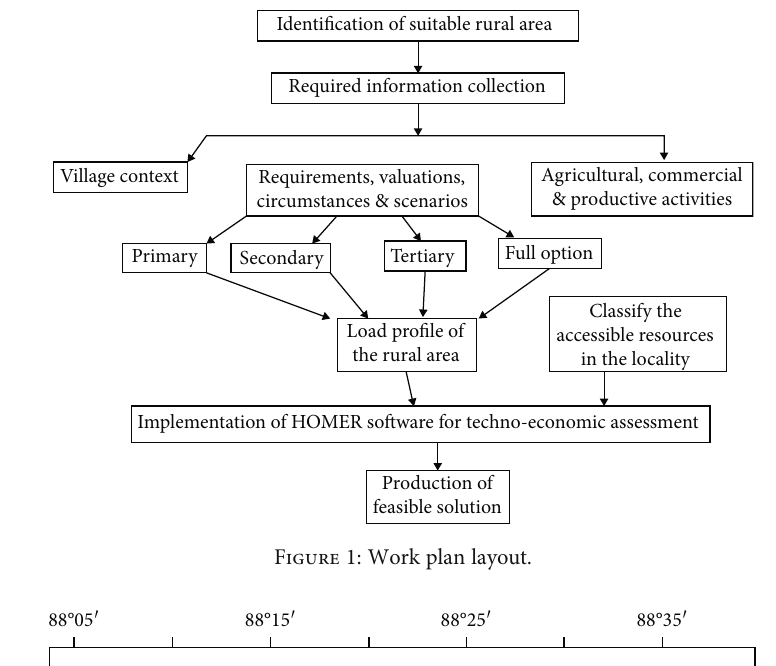
Figure 1: Work plan